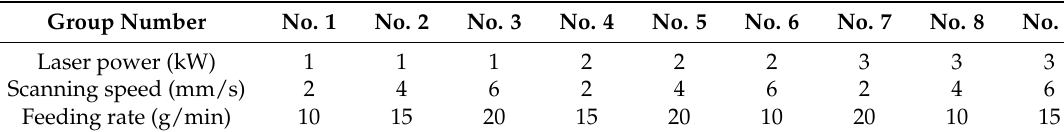
Figure 1. The morphology of Fe-based alloy powder. Figure 2. Experimental setup: ( a ) overall experimental setup; ( b ) schematic of laser cladding process.